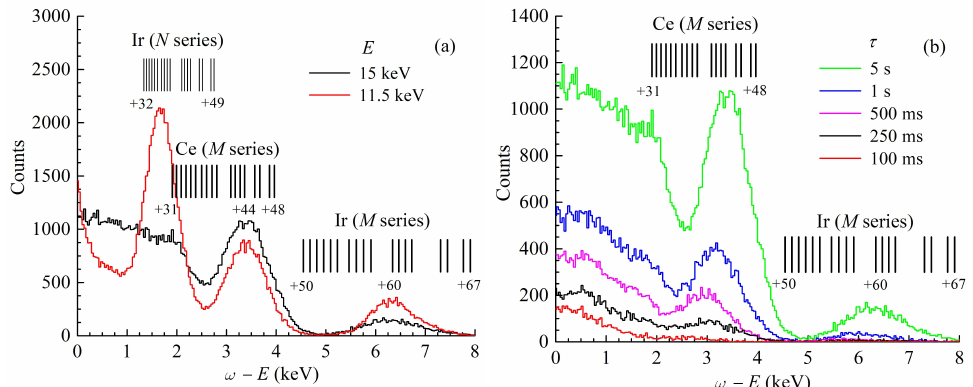
Figure 4. X-ray spectra of cathode materials. Photon energy ω is shifted by electron-beam energy E . ( a ) Permanent uncontrollable ion trap; observation during 24 h; electron current I = 20 mA; (red line) E = 11.5 keV; (black line) E = 15 keV. The vacuum measured in the vicinity of the cathode fell in the range (0.5–1) × 10 − 8 mbar. ( b ) Controllable ion trap; confinement time τ in the range from 100 ms to 5 s; E = 15 keV; I = 20 mA; j ∼ 1 kA/cm 2 . Binding energies of ions in various charge states + q are shown by vertical